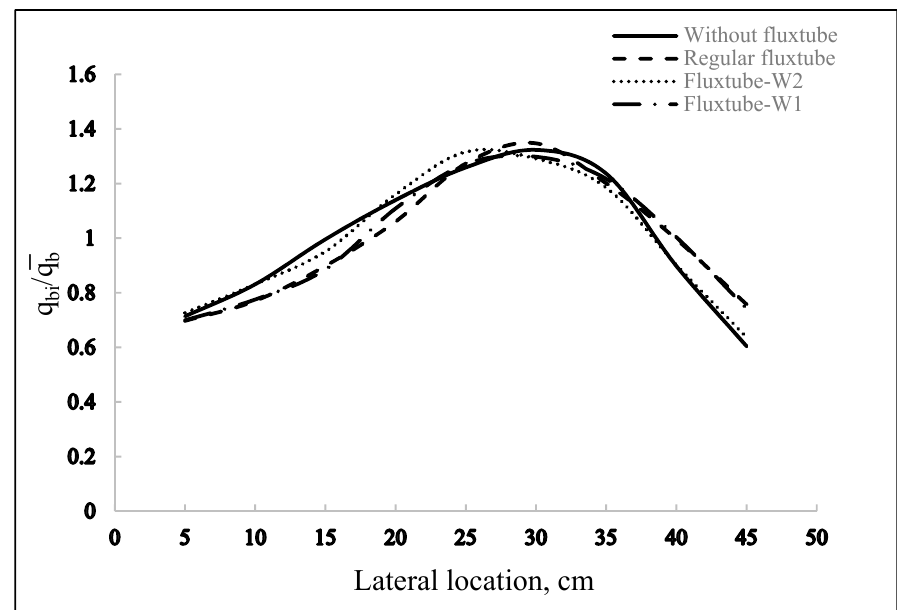
Figure 15. Radial gas bubble distribution profile at injection level using the asymmetrical baffle without a fluxtube and with fluxtubes of different widths under the superficial gas 0.4 m/s with even gas inlet configuration.